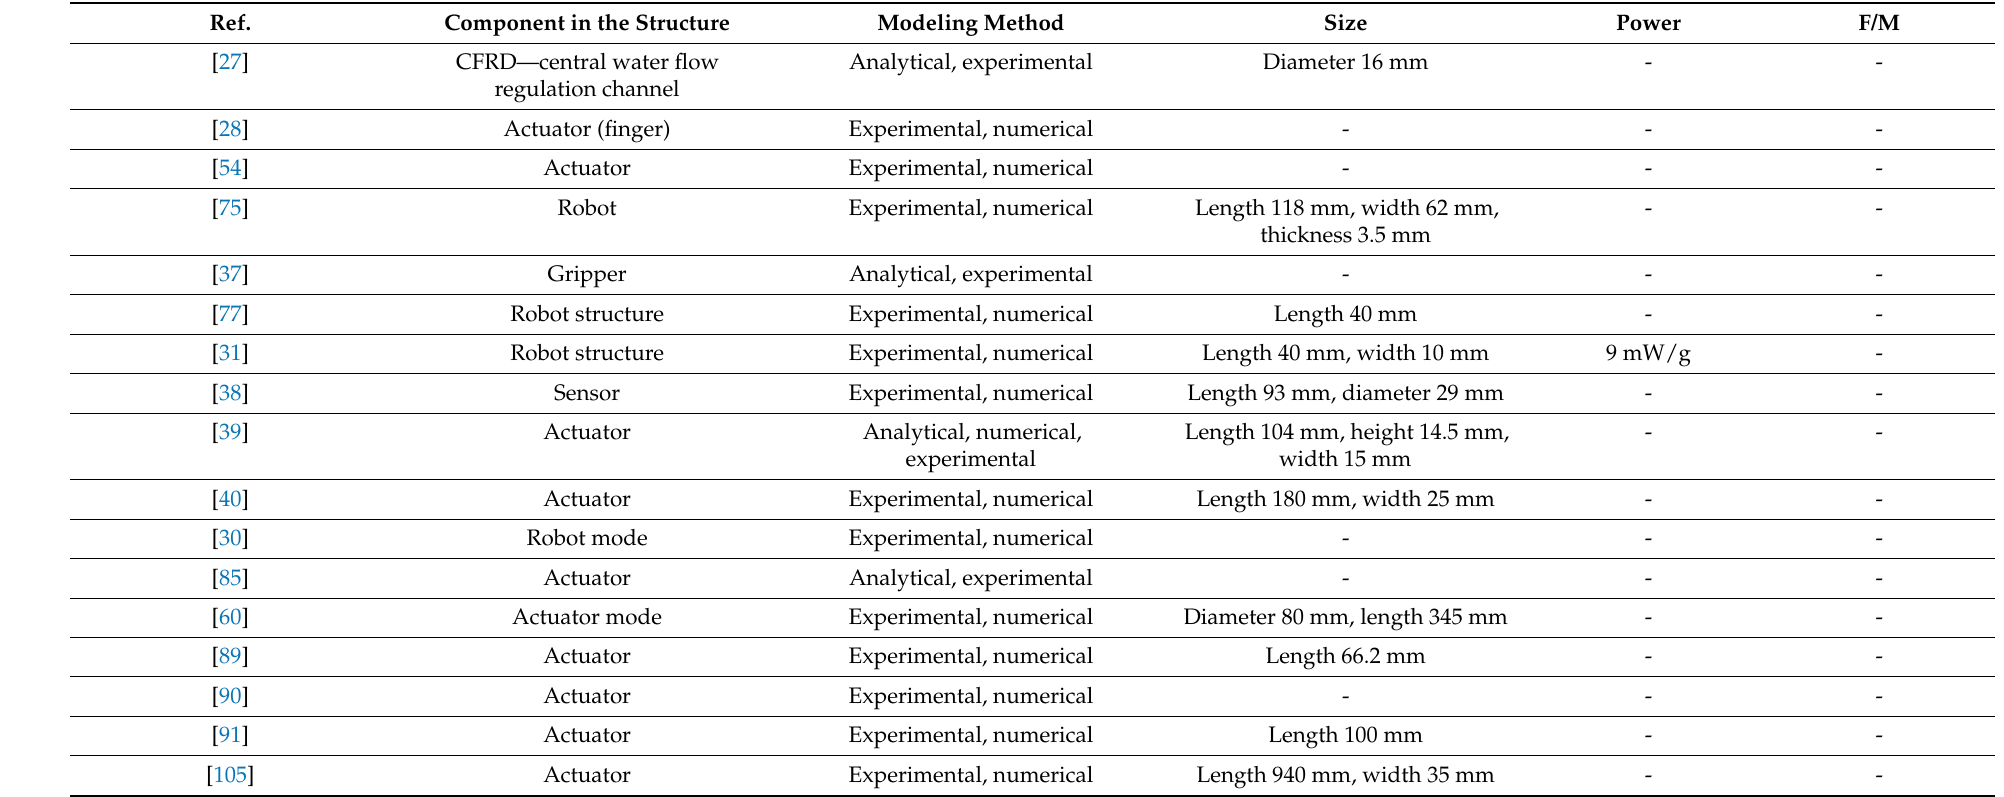
Table A5. Analysis of references according to the modelling methods.